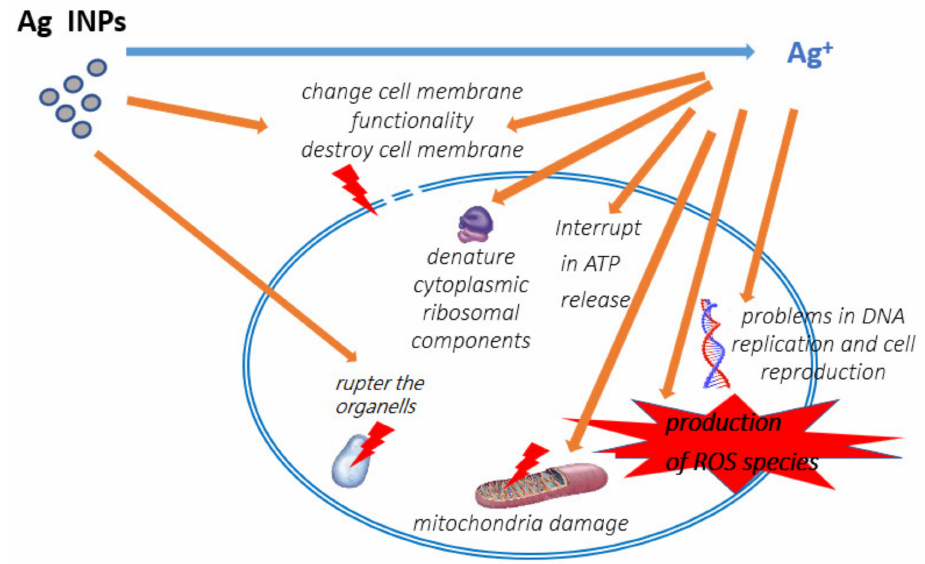
Figure 1. Supposed mechanisms of action of Ag INPs as antimicrobial